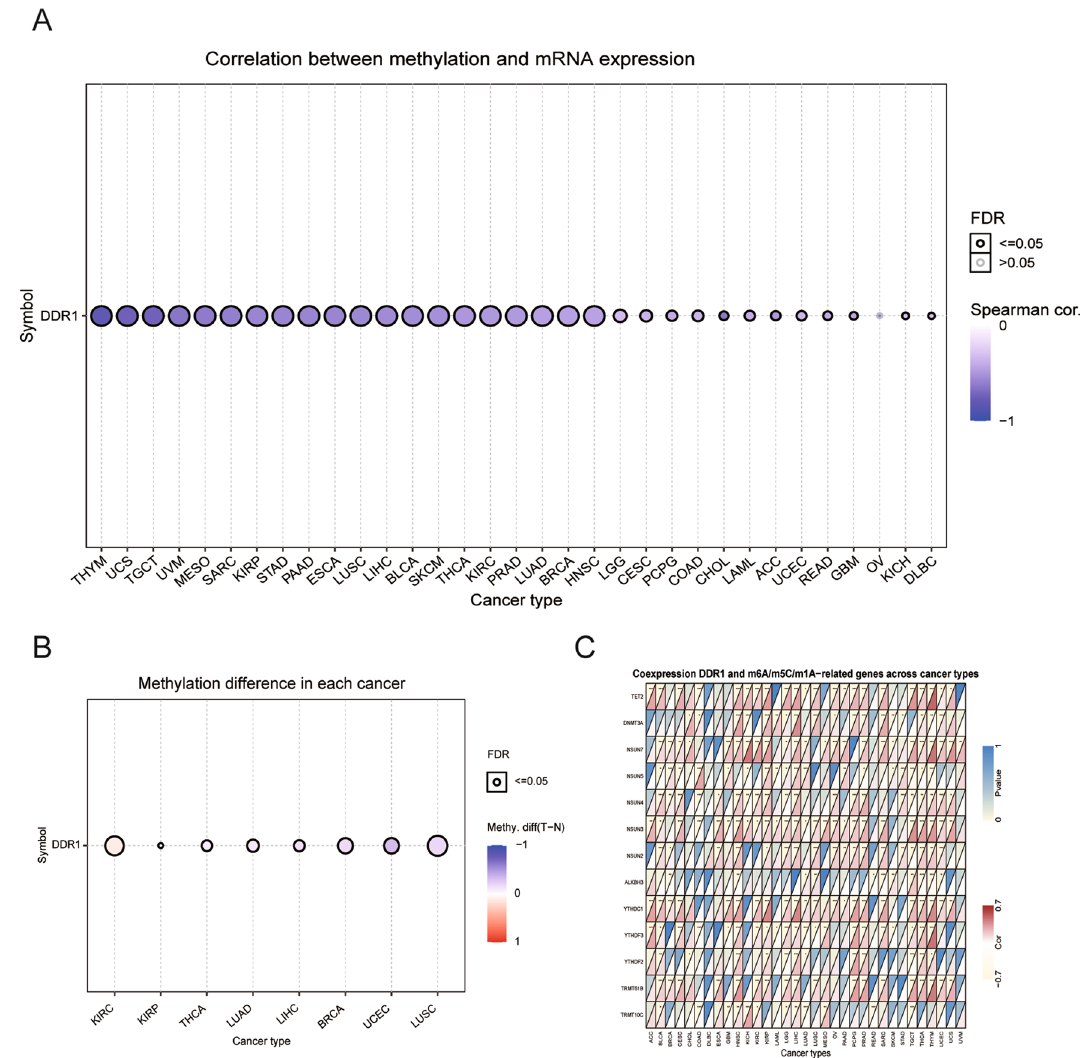
Figure 2. Association between DDR1 expression and DNA methylation and m6A-, m5C-, and m1A-related genes across cancers. ( A ) Correlation between methylation and mRNA expression levels of DDR1. ( B ) Methylation differences in DDR1 mRNA in different cancers. ( C ) Heatmap illustrating the relationship between DDR1 and m6A-, m5C-, and m1A-related genes. The top left triangle represents the P-value, and the bottom right triangle represents the correlation coefficient. * P < 0.05, ** P < 0.01, *** P <